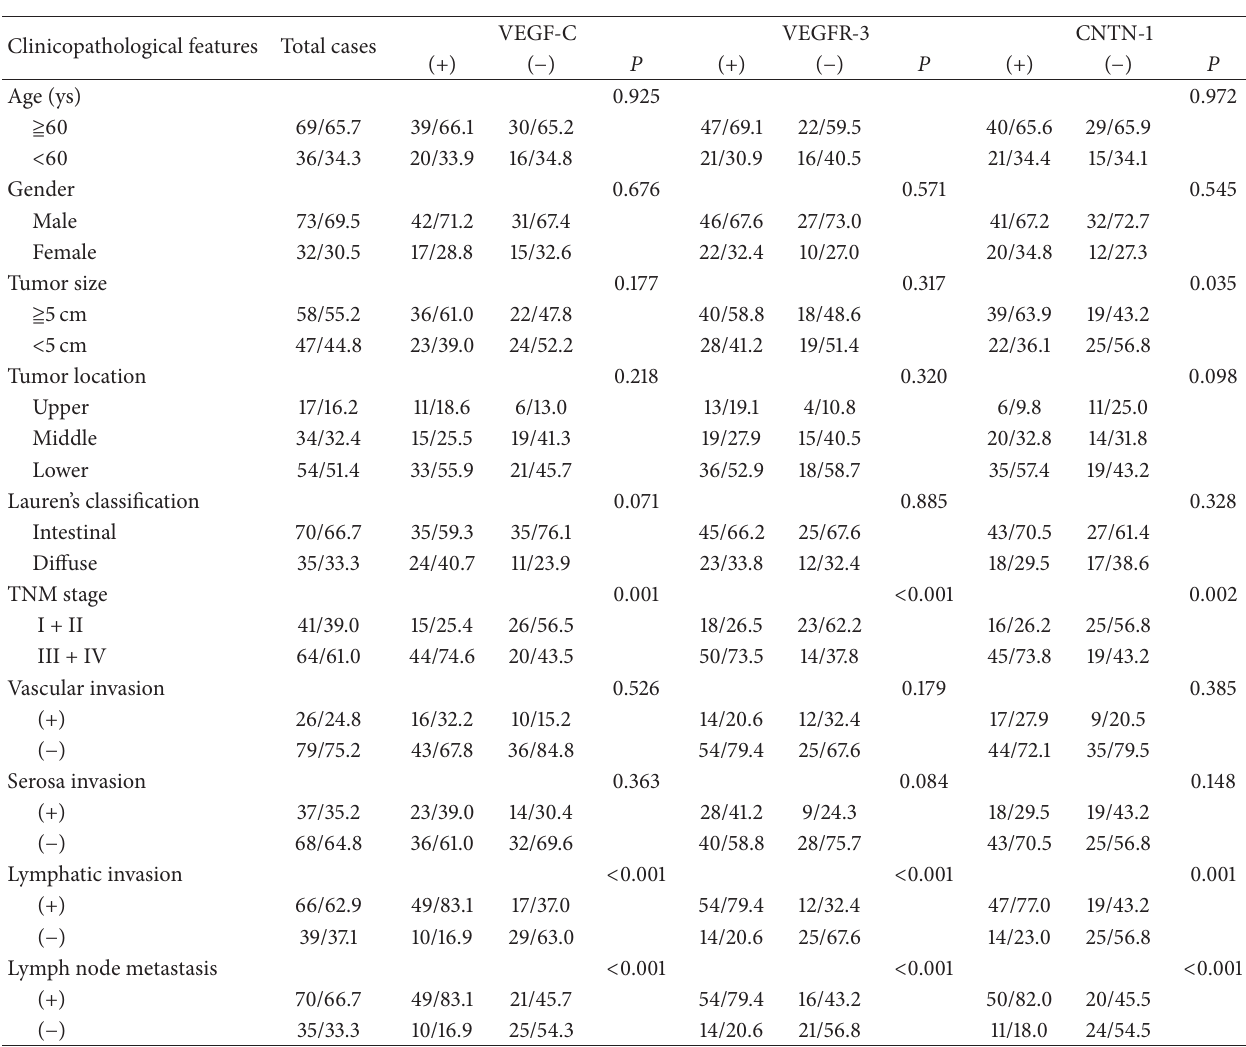
Table 3: Correlation of clinicopathologic parameters with VEGF-C, VEGFR-3, and CNTN-1 expression in gastric cancer ( 𝑛